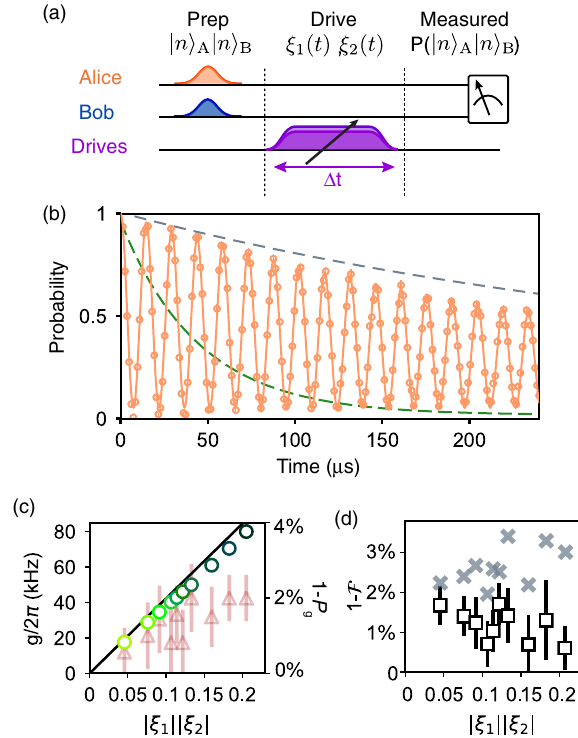
FIG. 2. Calibration of bilinear coupling. (a) General measure- ment protocol. After preparing the cavities in the desired initial state, we apply the drives for a variable amount of time before measuring the final joint memory state using a photon- number selective π pulse on qC. (b) Measured P 10 (orange circles) with the engineered interaction at j ξ 1 jj ξ 2 j ≈ 0 . 12 . Data are normalized by a constant scaling factor to calibrate out the state preparation and measurement errors [23]. Solid line shows fit to the functional form P 10 ∝ e t= τ 1 ½ 1 þ e t= τ ϕ sin ð 2 π tf Þ(cid:2) . Dashed lines are the intrinsic decays from j 1 i (gray) and relaxation A of j e i (green) of qC. (c) Measured coupling strength g= 2 π (green circles) as a function of the drive strength j ξ 1 jj ξ 2 j . Data are consistent with the predicted behavior (black line) based on the fourth order cosine expansion, but deviate at higher drive powers. Measured excited state population of qC (red triangles), after a single BS operation. (d) Measured infidelity of a BS as defined by τ =T at different drive powers with (black squares) and BS BS without (gray crosses) postselecting on qC remaining in its ground state after the operation.